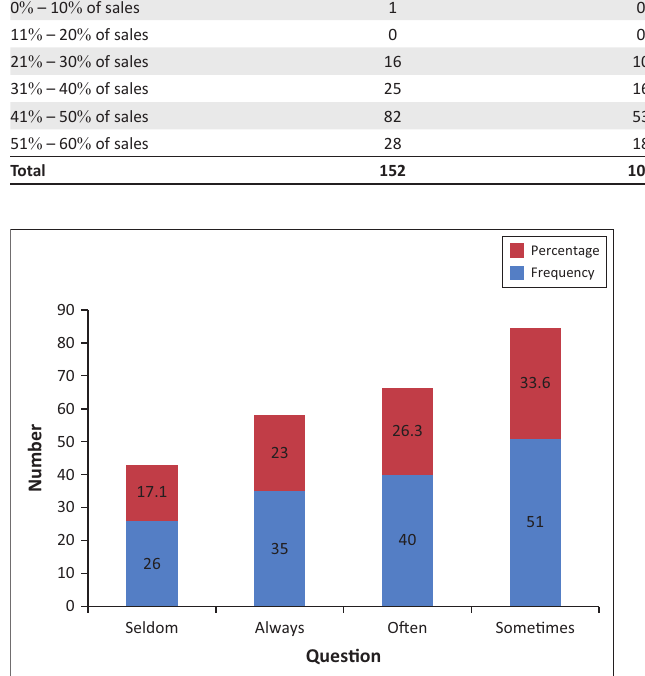
FIGURE 1: Distribution of late payment by debtors.